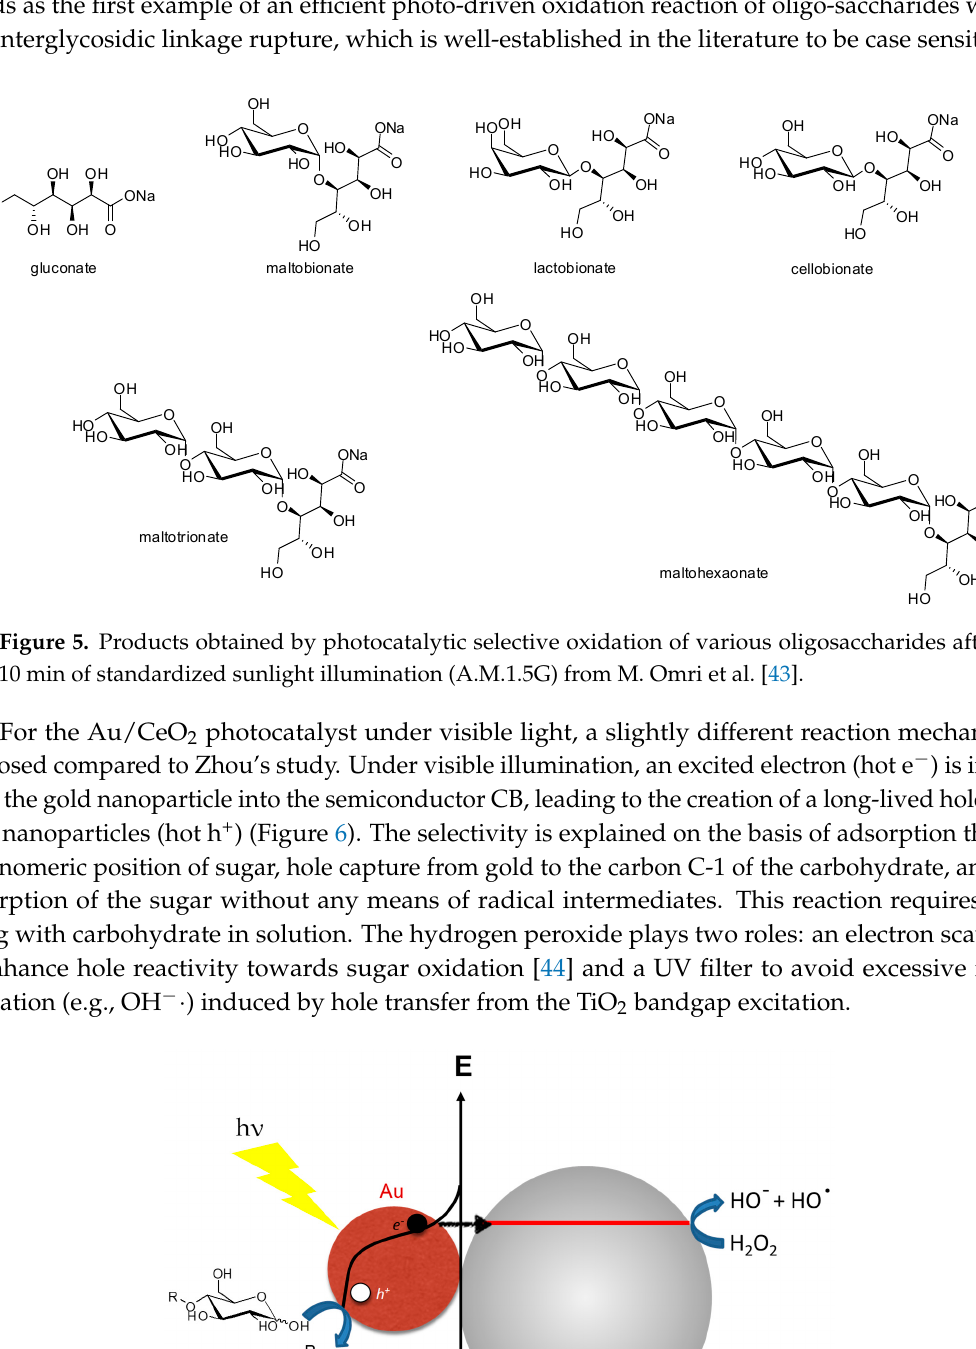
11 of 22 Figure 4. HR-TEM images of Au/CeO 2 photocatalysts obtained from M. Omri et al. [43].